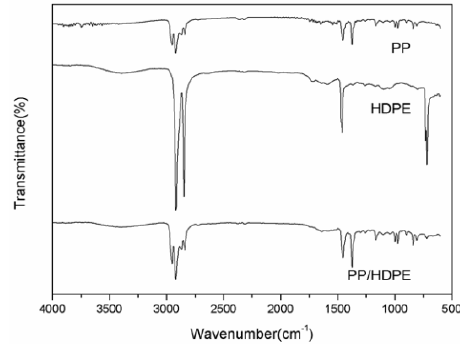
Figure 3. Fourier transform infrared spectroscopy (FTIR) spectra of of PP/HDPE polyblends.